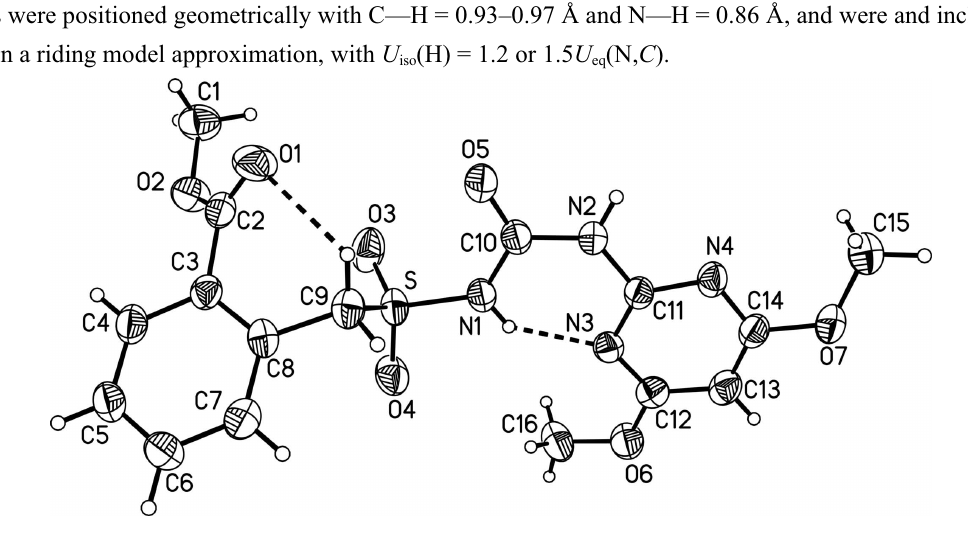
Figure 1 The molecular structure of (I). Displacement ellipsoids are drawn at the 50% probability level. Dashed lines indicate intramolecular hydrogen